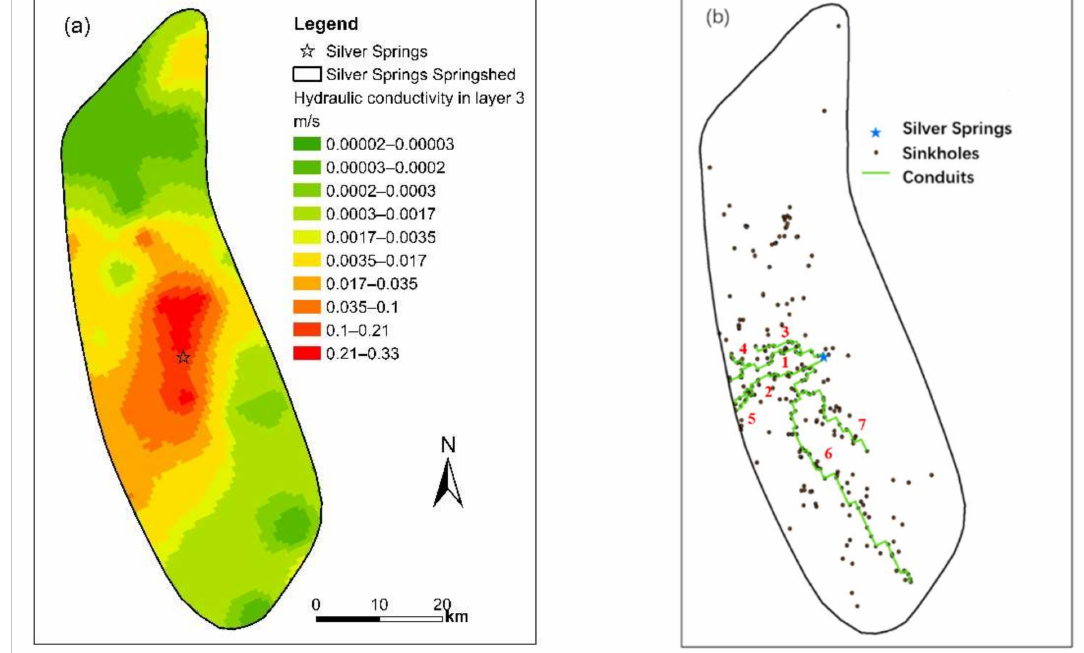
Figure 5. ( a ) Hydraulic conductivity values set in layer 3 of the EPM model [31]; ( b ) the delineated conduits in the UFA and the distribution of sinkhole locations in the